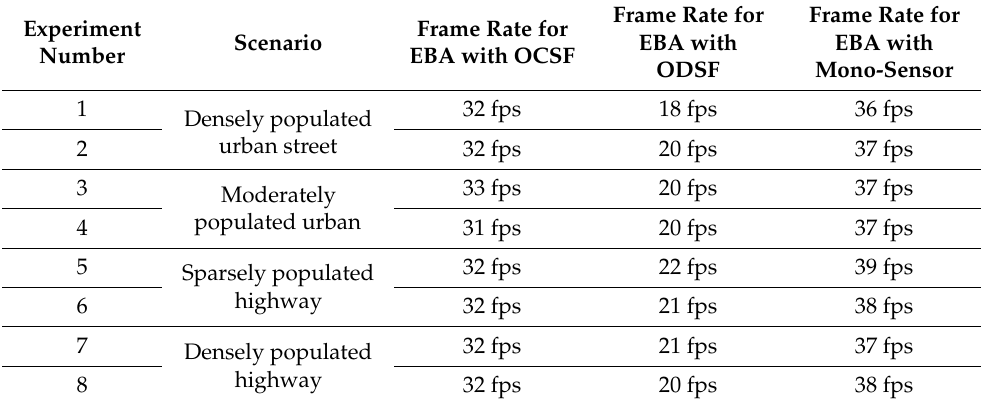
Table 5. Frame rate for multiple videos for OCSF- and ODSF-driven EBA.